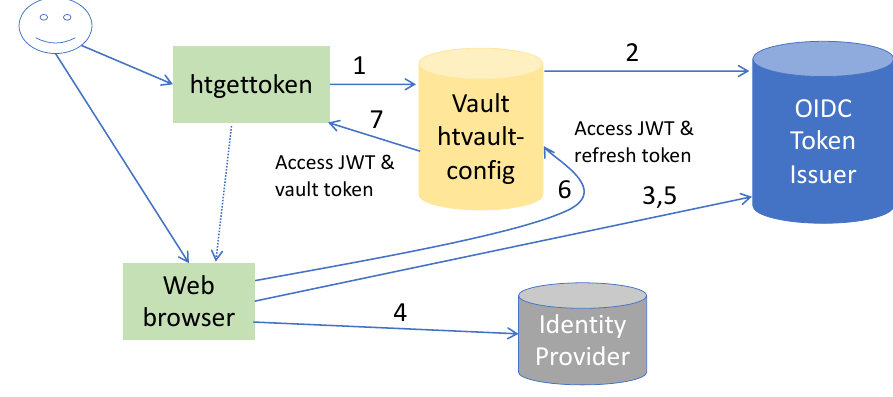
Figure 1. OIDC flow with vault and